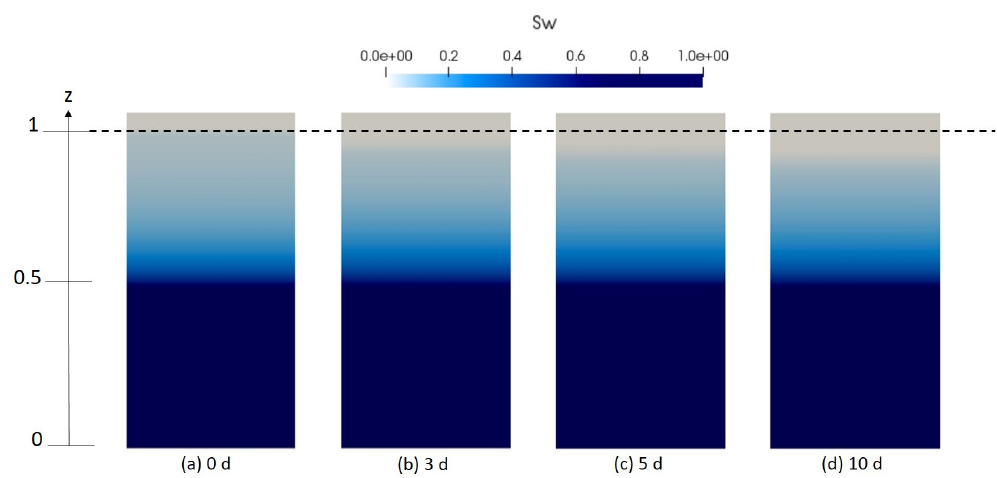
Figure 8. Numerical results depicting the spatial distribution of water saturation in the sand column for different time intervals ( a ) initially and after ( b ) 3 days, ( c ) 5 days, ( d ) 10